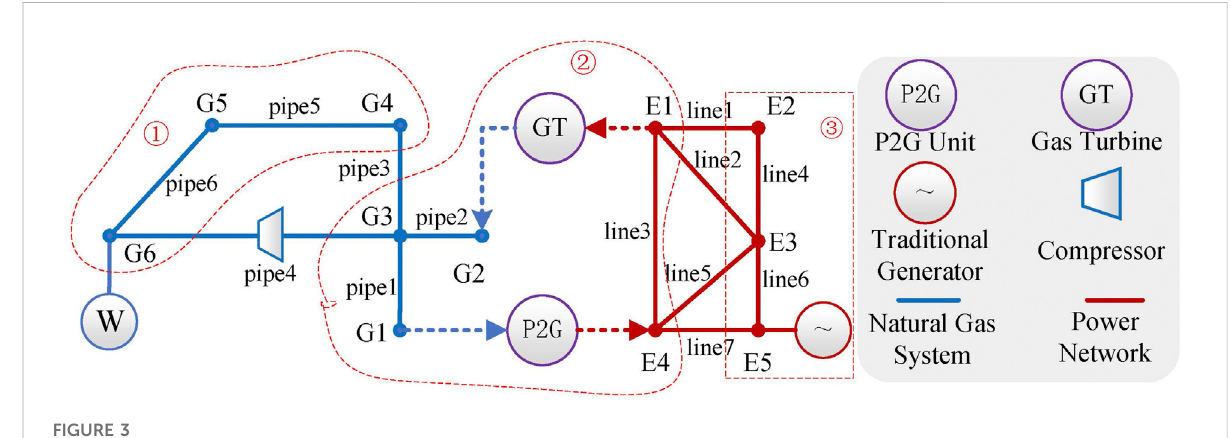
FIGURE 3 Schematic diagram of system node partition.